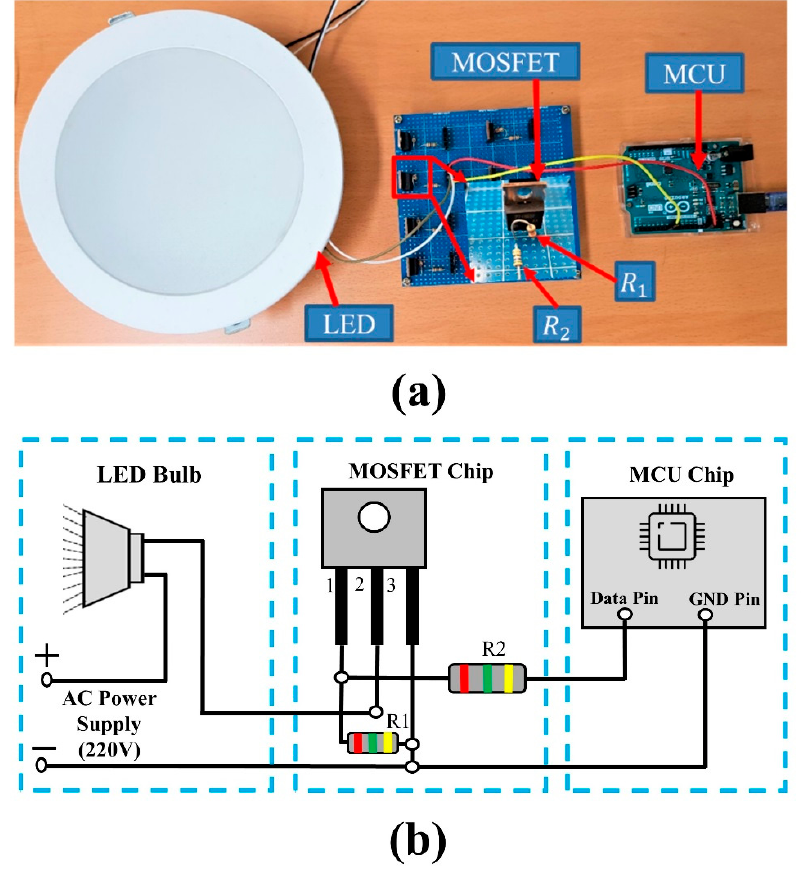
Figure 1. ( a ) Simple transmitter circuit including its parameter; ( b ) the electrical schematic of trans- mitter circuit with its connection design. transmitter circuit with its connection